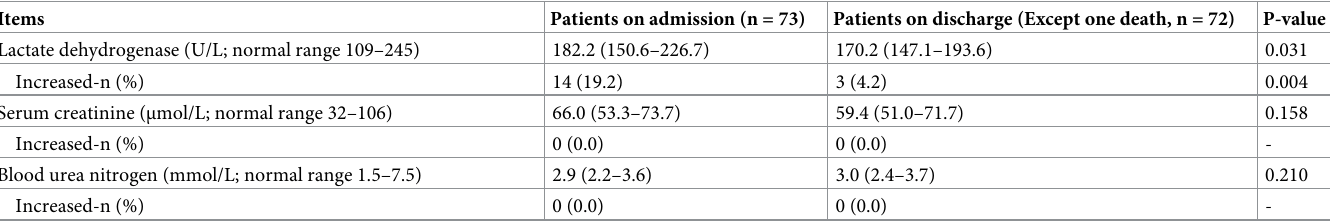
using the aforementioned regimen. They were 3 women and 1 man, with median age of 60.0